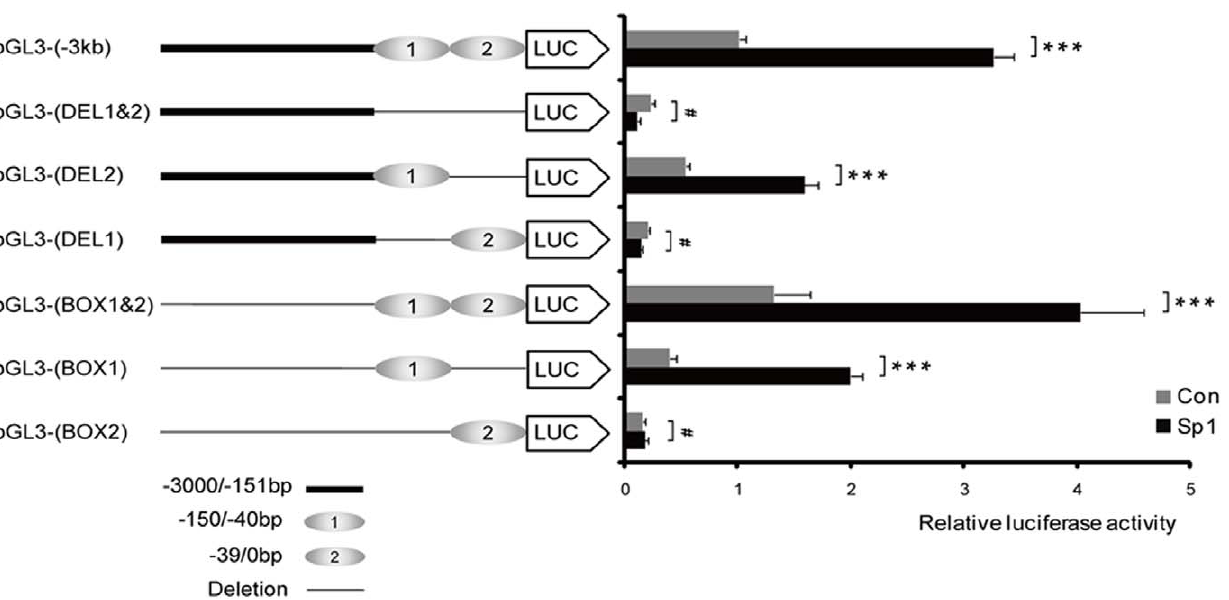
Figure 4. EMSA test indicates that Sp1 directly binds to the GC-boxes of the MGARP promoter. For the EMSA analysis, nuclear extracts (Nu) from HEK-293T or Y1 cells were incubated with Biotin-labeled oligonucleotides (Biotin-probe) spanning the GC-rich region (BOX1) of the MGARP promoter ( 2 3 kb). Competition reactions were performed with 200X of unlabeled cold competitor (cold), 200X of mutated-labeled competitors (mu) or Sp1 antibody (2 m g). The following cell lines were used: non-transfected or Sp1-overexpressed HEK-293T cells (A), non-transfected, Sp1- overexpressed, or 630-RNAi transfected HEK-293T cells (B), and Y1 cells (C).